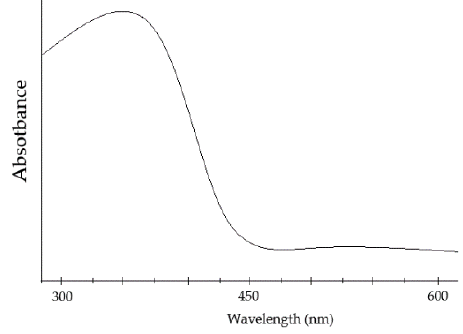
Figure 27. Light absorption curve of Bi 2 Fe 4 O 9.